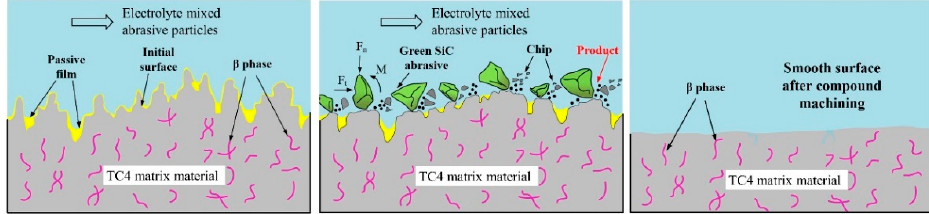
Figure 18. Model of material removal by ECFAP in 10% NaNO 3 .